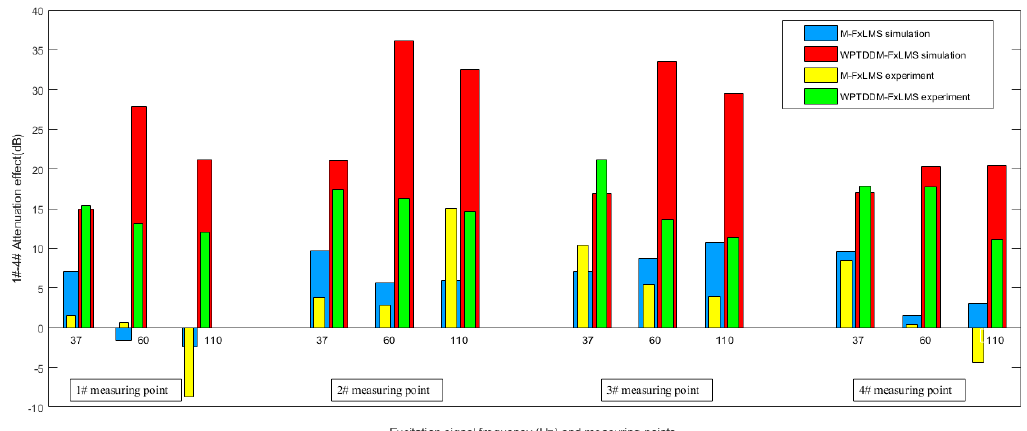
Figure 20. The comparison of the theoretical simulation and experimental verification.